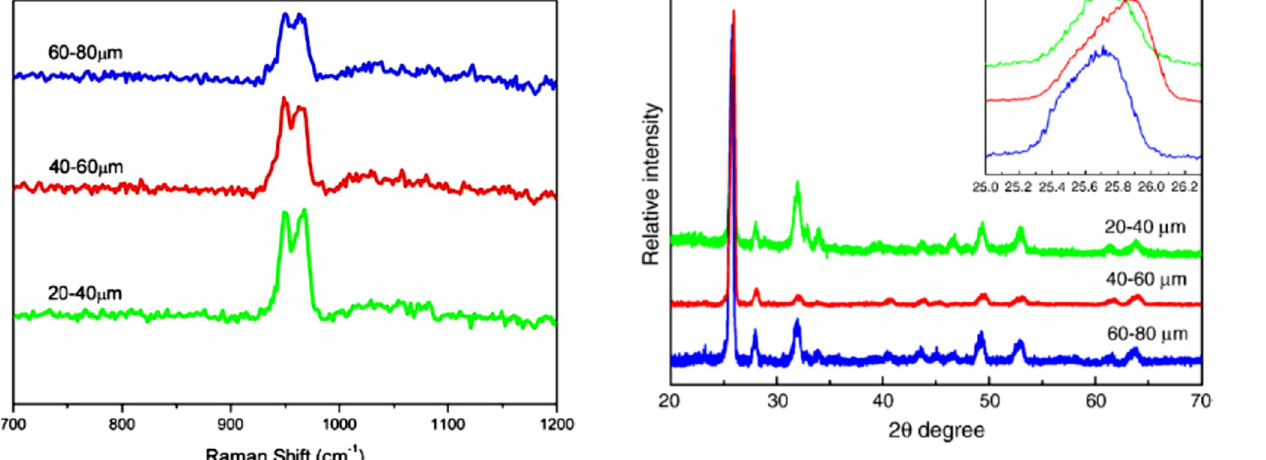
Fig. 3 Micro-Raman spectra of coatings [65]